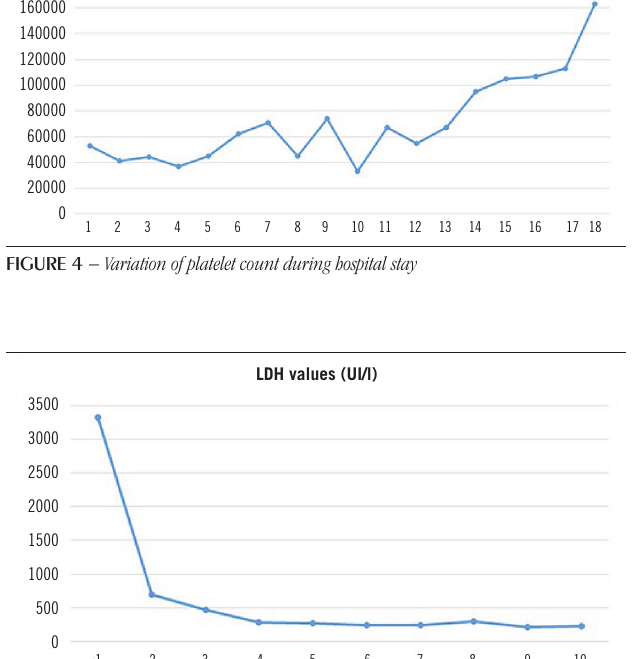
Platelet count (/mm 3 )